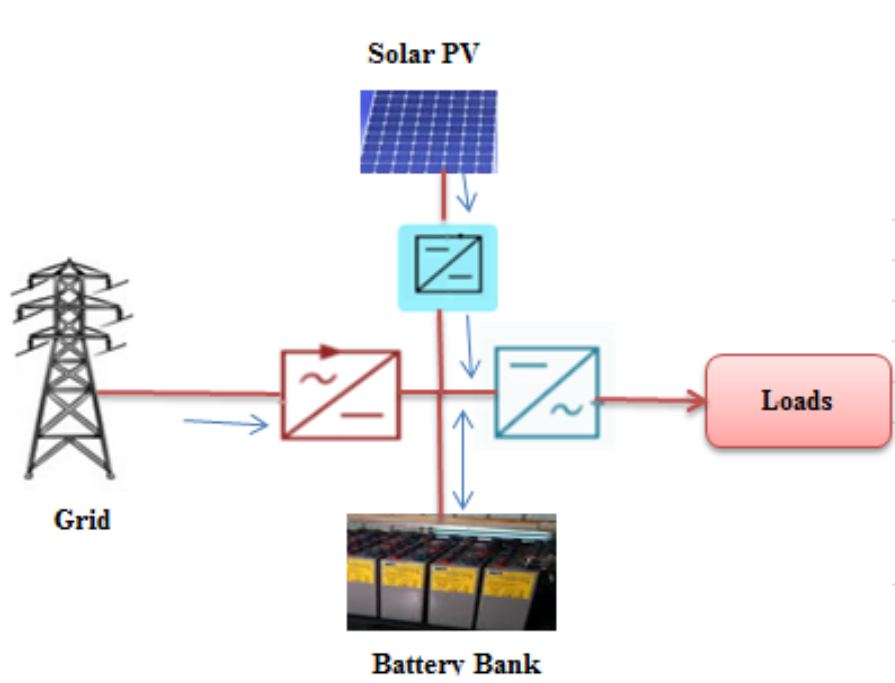
Figure 8. General scheme of the joined grid-tied/off-grid solar power system.